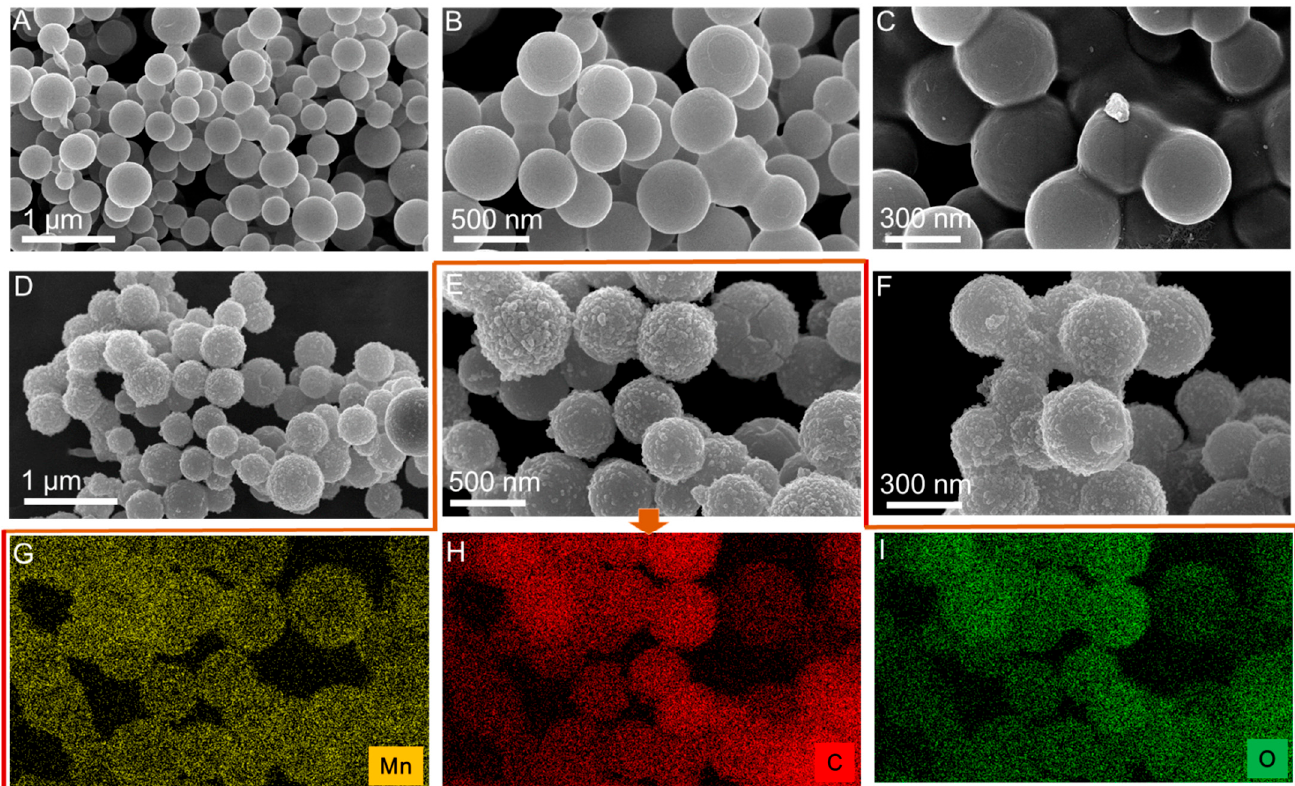
Figure 7. HR − TEM pro fi le of sample 0.05MnC − 30 − 500.